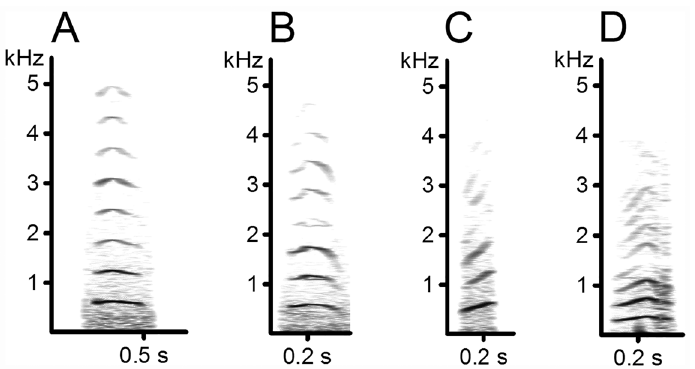
Fig 1. Spectrograms of rhesus female coo calls. Coo call of subject A and B have a relatively high similarity (i.e., a low F-value of 0.97), whereas the coo calls of subject C and D have a low similarity (high F- values of 6.71). F-values for the other combinations: A vs. C = 4.5, A vs. D = 3.7, B vs. C = 4.63, B vs. D =